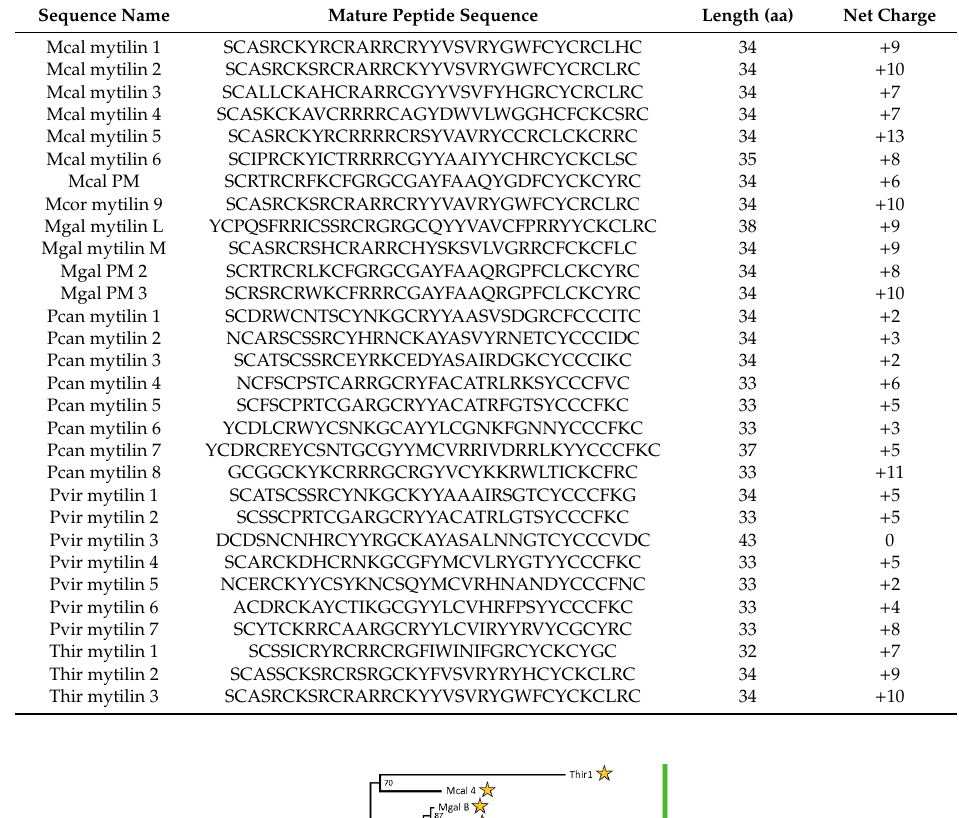
Table 1. List of the novel mytilin sequences identified in this study. Cysteine residues are highlighted in bold. PM: pseudomytilin; Mcal: M. californianus ; Mcor: M. coruscus ; Mgal: M. galloprovincialis ; Pcan: